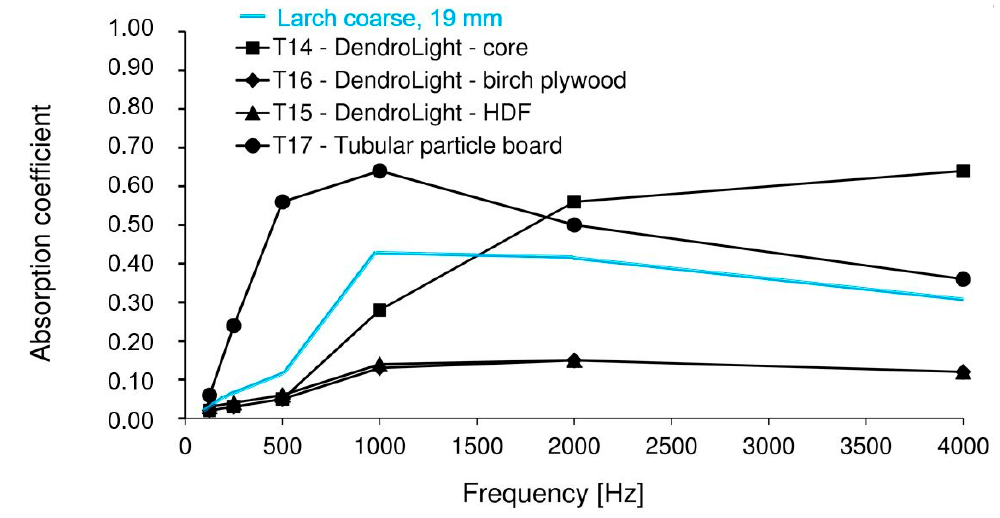
Figure 6. Dependence of the sound absorption coefficient on frequency for wood-based composites with a thickness 22.3 < x < 28 mm and a density 220 < y < 500 kg/m³ (after Smardzewski et al. [9]).